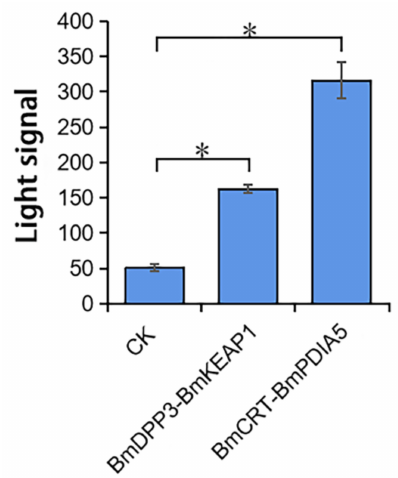
Figure 3. Verification of the interactions of two groups of proteins by I2H. The star (*) indicates the significant difference between two groups ( p <